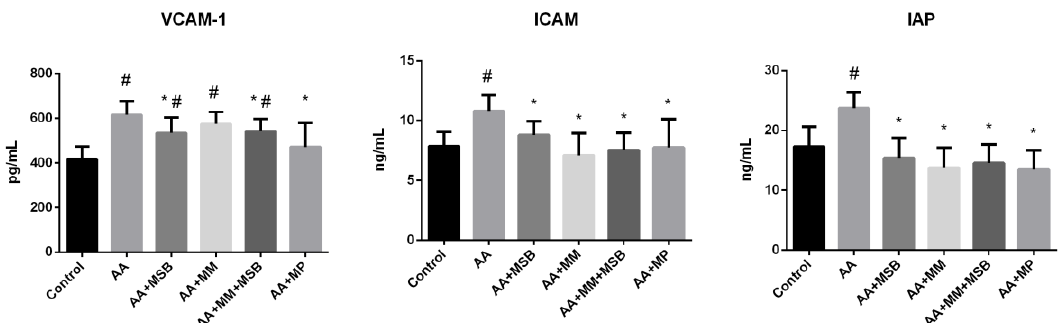
Figure 3. Serum VCAM-1, ICAM-1, and IAP levels. * p < 0.05 compared to AA; # p < 0.05 compared to control. Abbreviations: VCAM, vascular cell adhesion molecule; ICAM, intercellular adhesion molecule; IAP, intestinal alkaline phosphatase; AA, 4% acetic acid; MSB, MegaSporeBiotic™; MM, MegaMucosa™; MP, methylprednisolone. The bars represent mean values with standard deviations.